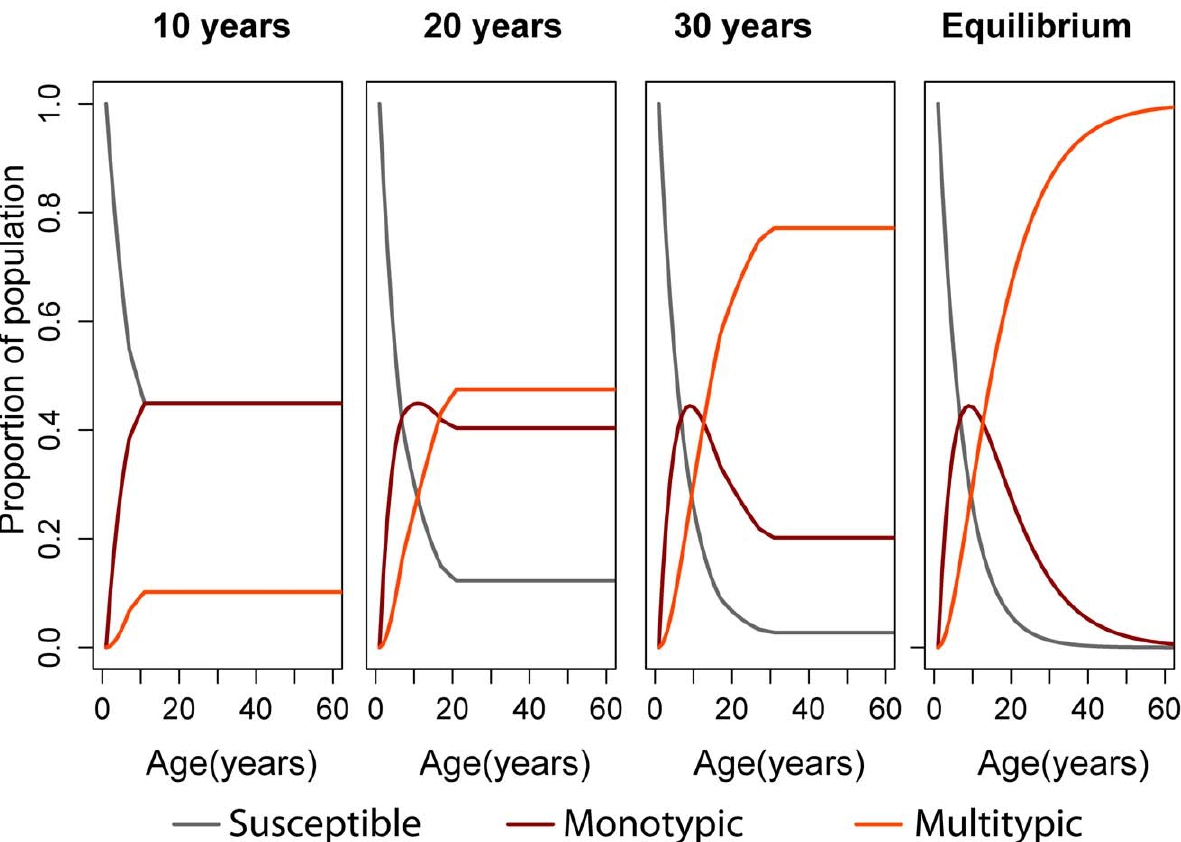
Figure 3. Discrete time simulation shows that as years go by, multitypic immunity accumulates among adults. Results of discrete-time simulation to show the accumulation of multitypic and monotypic immunity 10, 20, and 30 years after the introduction of dengue virus into a previously susceptible population, and at equilibrium. l (DENV 1, 2 and 3) =0.05.